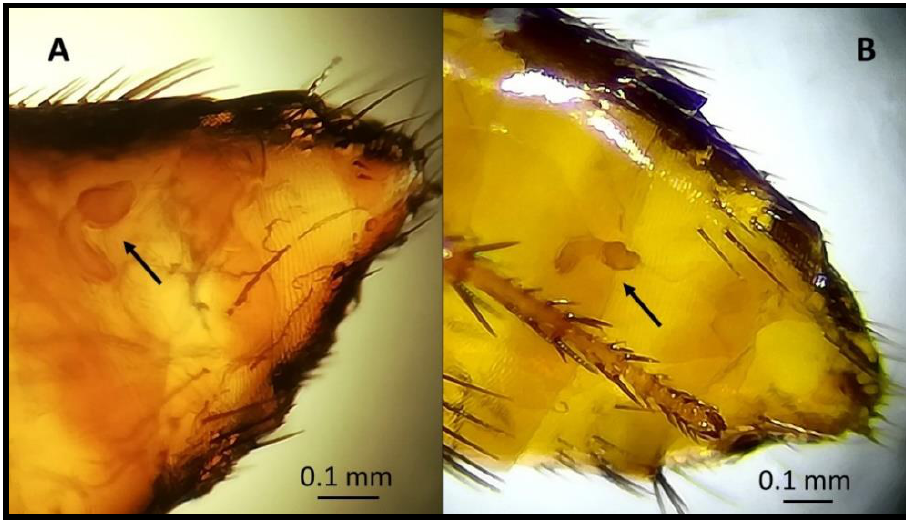
Figure 4. Head ( A ) of the spermatheca as long as the tail ( B ) (and tail without papilla). Molecular investigation carried out on these insects at the National Reference Labor- atory for Tularemia (Istituto Zooprofilattico Sperimentale della Lombardia edEmilia Ro- magna) did not detect any positive samples for F. tularensis